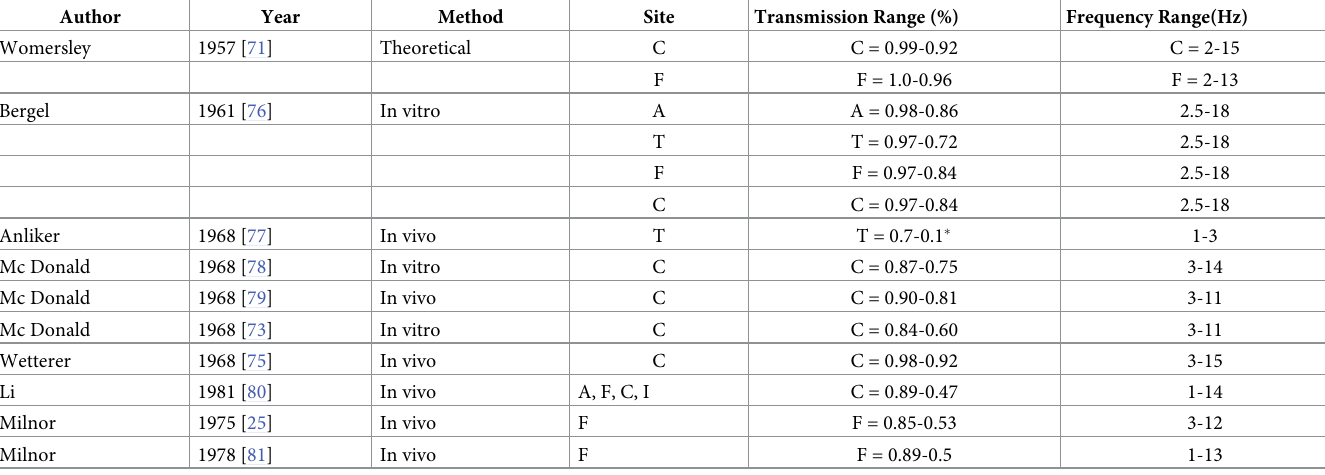
Table 4. Summary of studies in vascular flow related pulse wave